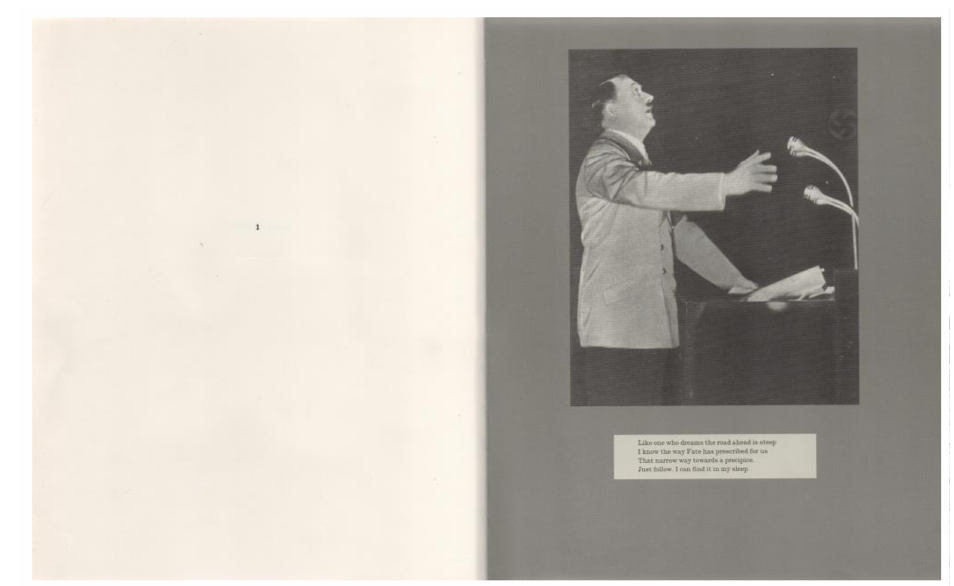
Figure 8. Plate 1. Bertolt Brecht. 1998. War Primer . London: Libris.